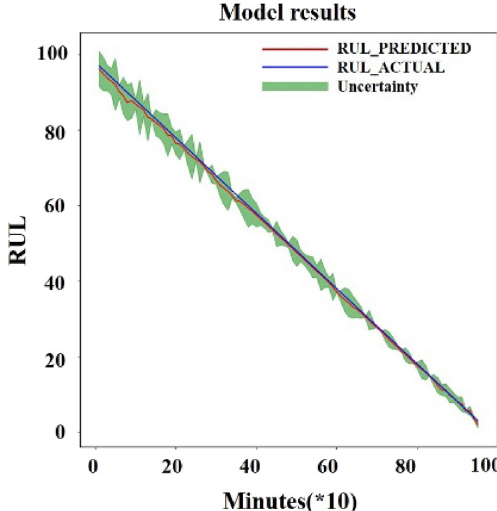
Figure 14. Test result with uncertainty in dataset 2.